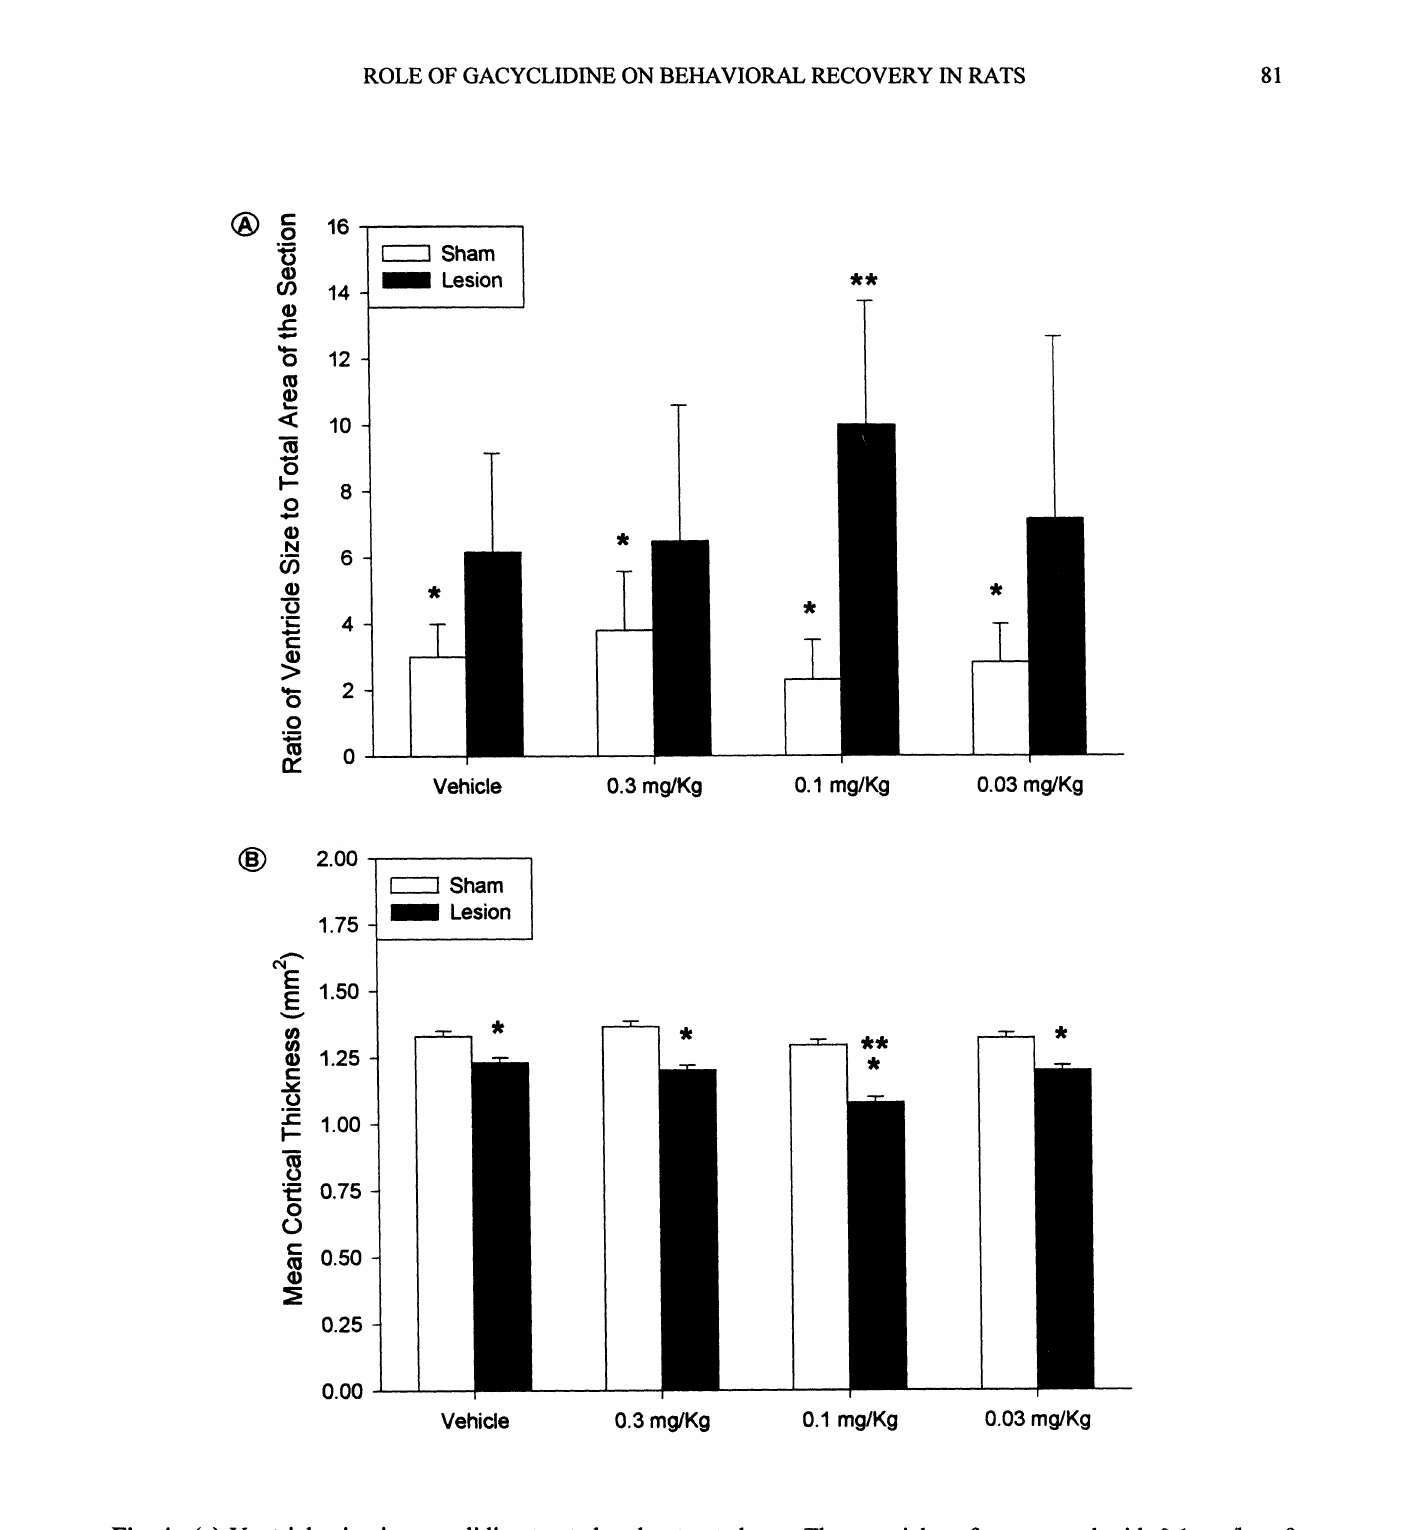
Fig. 4: (a) Ventricle size in gacyclidine-treated and untreated rats. The ventricles of rats treated with 0.1 mg/kg of gacyclidine were significantly larger than those in untreated animals with similar lesions (*=p<0.05) and larger than those in rats given either 0.3 or 0.03 mg/kg of gacyclidine (**=p<0.05). Nonsignificant ventricular enlargement was noted in sham-operated rats given the 0.3 mg/kg dose of gacyclidine. (b) Cortical thickness in gacyclidine-treated and untreated rats. Rats treated with the 0.1mg/kg dose of gacyclidine of showed a decrease in cortical thickness measured at several locations (**=p<0.05) when compared with contused rats given only vehicle. All animals receiving lesions of the MFC had thinner cortices (*=p<0.05). Sham-operated controls, regardless of dose, showed no change in cortical